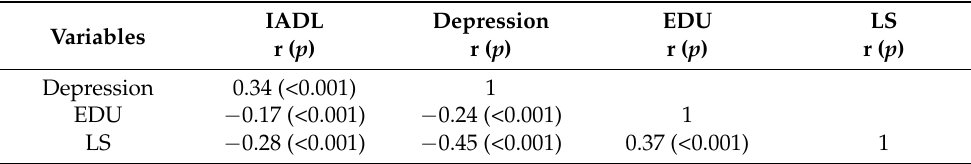
Table 3. Correlation among study variables ( n = 9906).